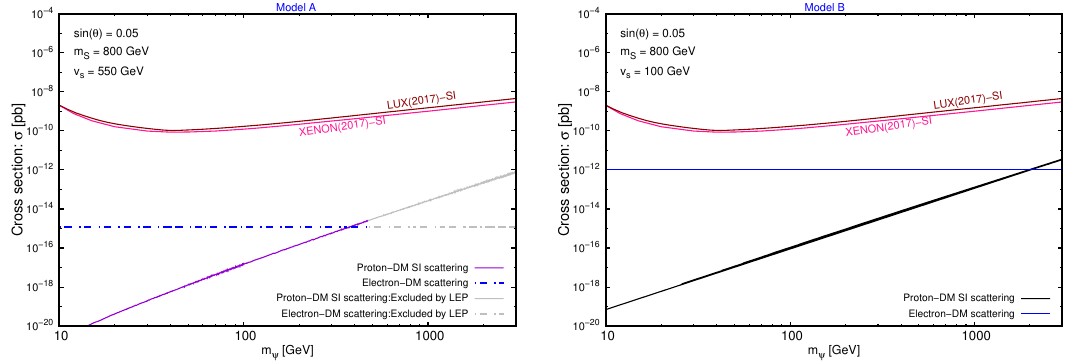
Figure 5 . Cross sections for nucleon-DM scattering and electron-DM scattering are shown in terms of the DM mass with m s = 800 GeV and sin (cid:18) = 0 : 05 and results are compared for left) model A and right) model B . In both (cid:12)gures the relic density is consistent with the observed value. Upper limits on the SI cross section provided by the XENON1t and LUX are imposed. The gray region is excluded by the LEP. The gray region is excluded by the LEP. The muon anomaly is applied in model A by taking 497 GeV < v s < 659 GeV in the scan. Other parameters in the scan are 10